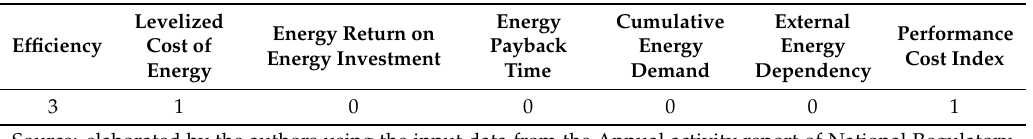
Table 1. Centralization of the main economic and environmental indicators at the t 0